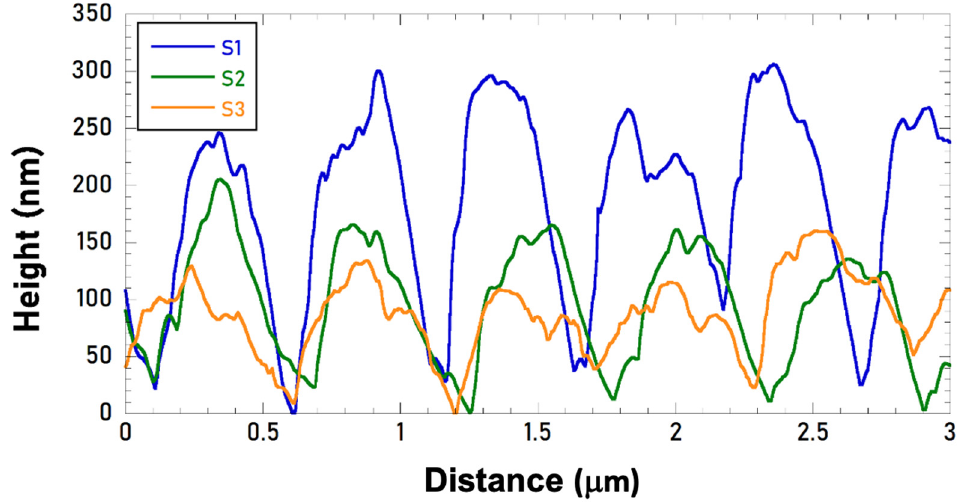
Figure 5. Measured surface profiles at the top of the nanostructured S1, S2, and S3 samples.